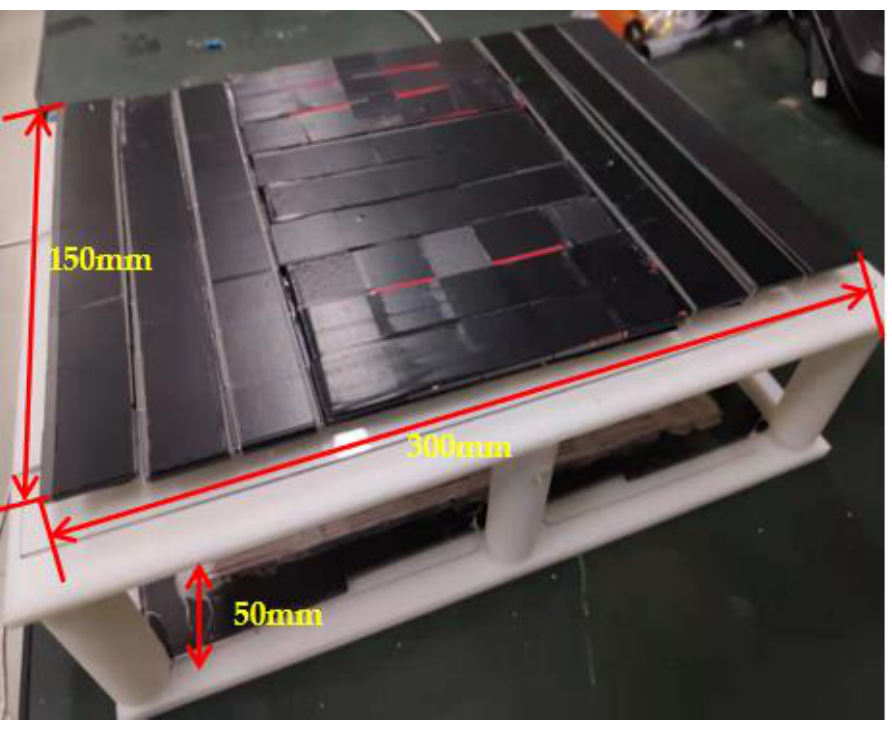
Figure 27. Traditional ferrite structure.